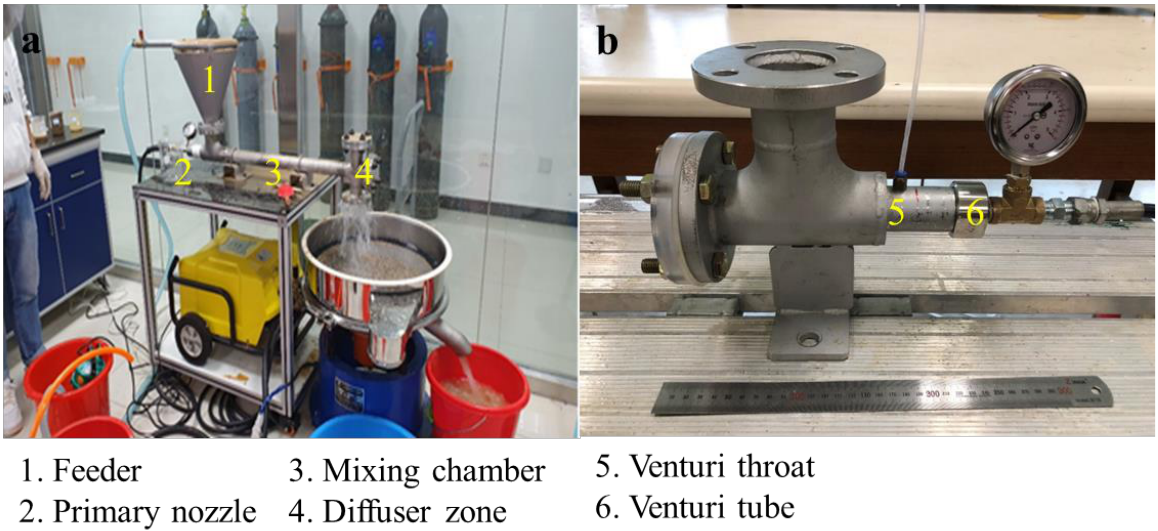
Figure 1. ( a ) The photo of the washing ejector and ( b ) the cavitating